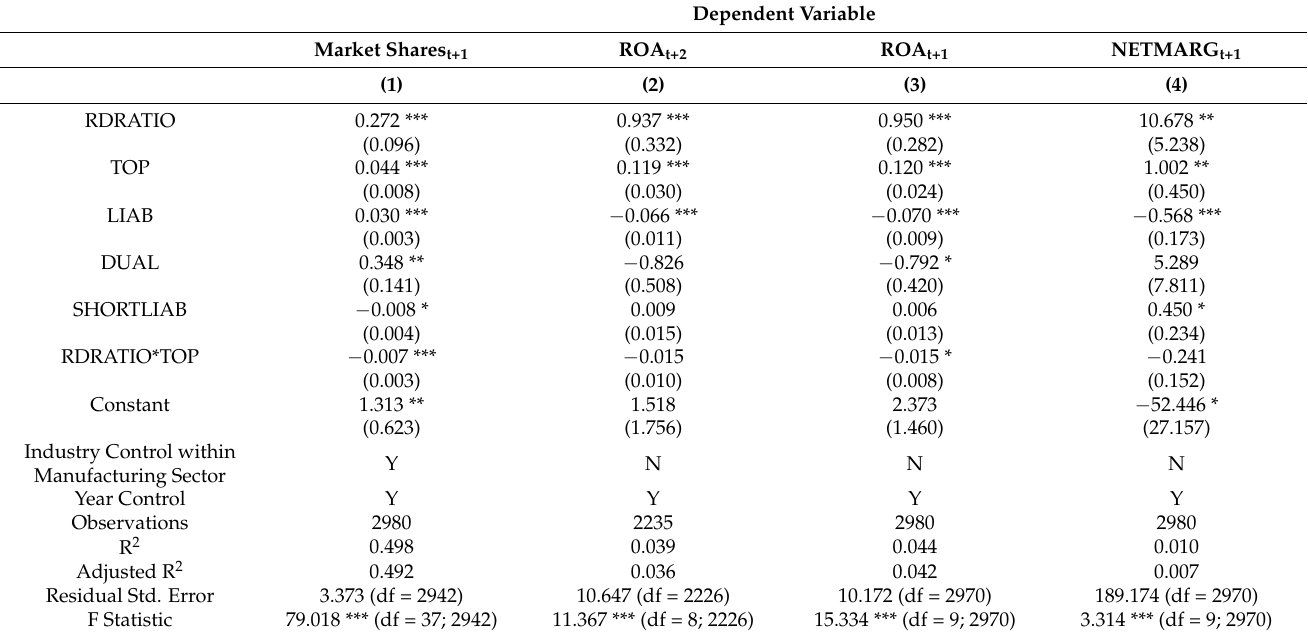
Table 7. Shenzhen exchange listed